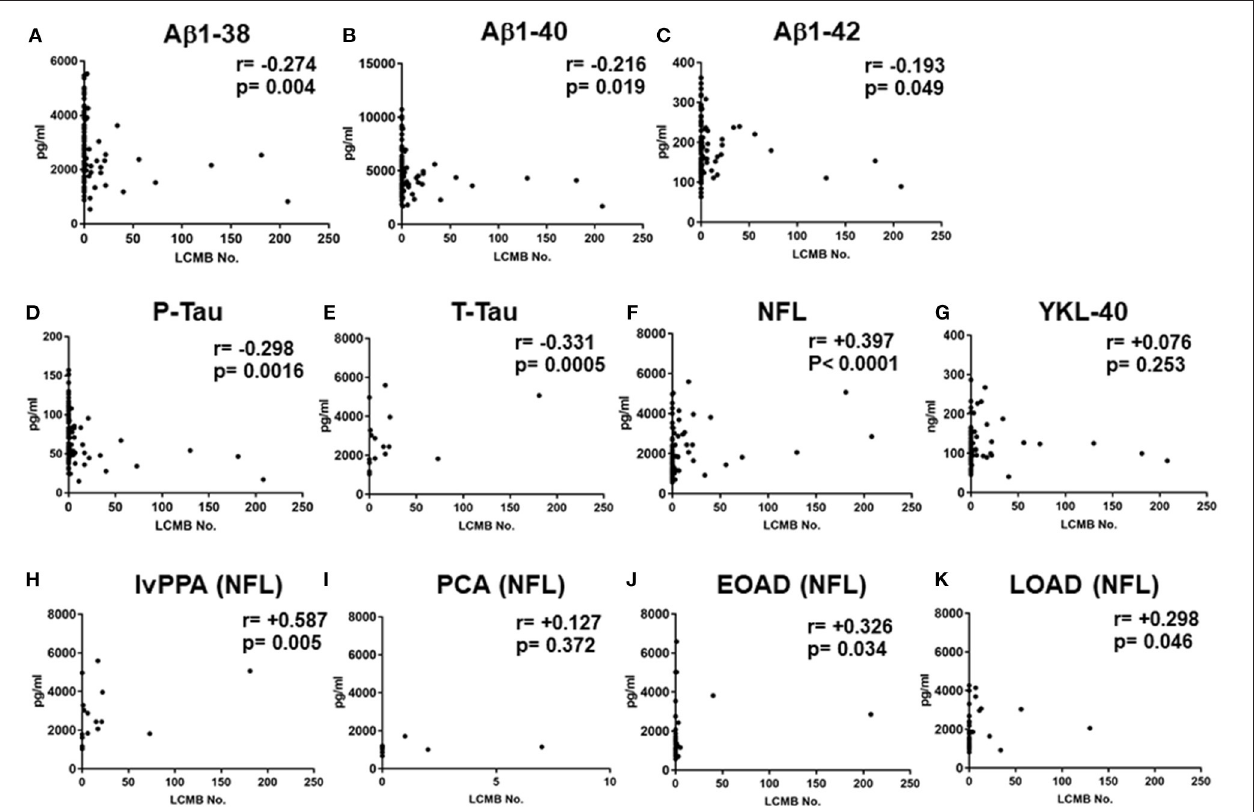
The levels of CBF volume were significantly correlated with the number of lobar CMBs at the left temporal lobe (r = − 0.382, p = 0.046) in lvPPA, and at the right and the left temporal lobes (r = − 0.345, p = 0.042; r = − 0.368, p = 0.027, respectively), at the right and the left parietal lobes (r = − 0.397, p = 0.020; r = − 0.345, p = 0.042, respectively), and at the right and the left occipital areas (r = − 0.353, p = 0.042; r = − 0.408, p = 0.043, respectively) in LOAD.